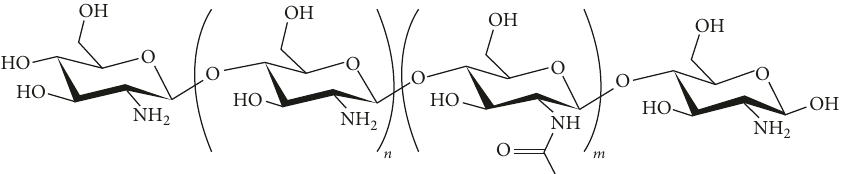
Figure 2: Chemical structure of chitin/chitosan. The index 𝑛 represents the number of repeat units of glucosamine in the chain and 𝑚 the number of repeat units of acetyl-glucosamine in the chain ( 𝑛 + 𝑚 indicating the degree of polymerization and 𝑚/𝑛 + 𝑚 being the degree of acetylation). When 𝑛 is more than 50%, the polymer is called chitosan. Content of NH 2 increases its reactivity [16, 25].